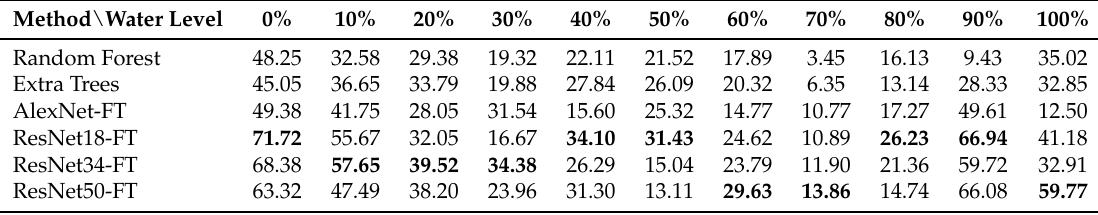
Table 7. Per-class F1 score for each method—Class10 training